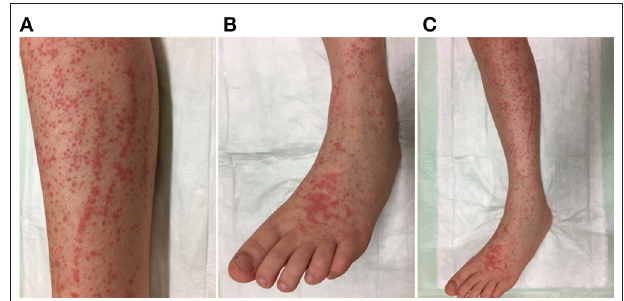
FIGURE 3 | Skin lesions: Rash, appearing within the first 5 days after onset of the neurological impairment with hives, with small red spots or bumps on the buttocks, lower legs (A,C) , knees, feet (B,C) , elbows, and hands. The rash affected both sides of the body equally and did not turn pale on pressing. Occasionally, classical purpura was noted. The lesions completely resolved within 2